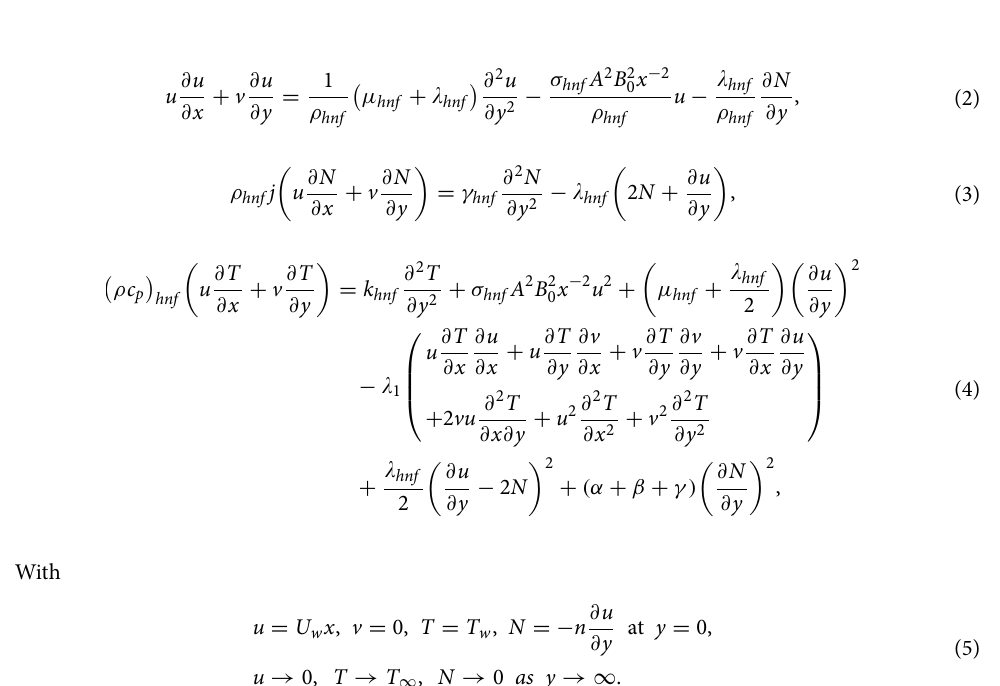
Figure 1. Fluid flow